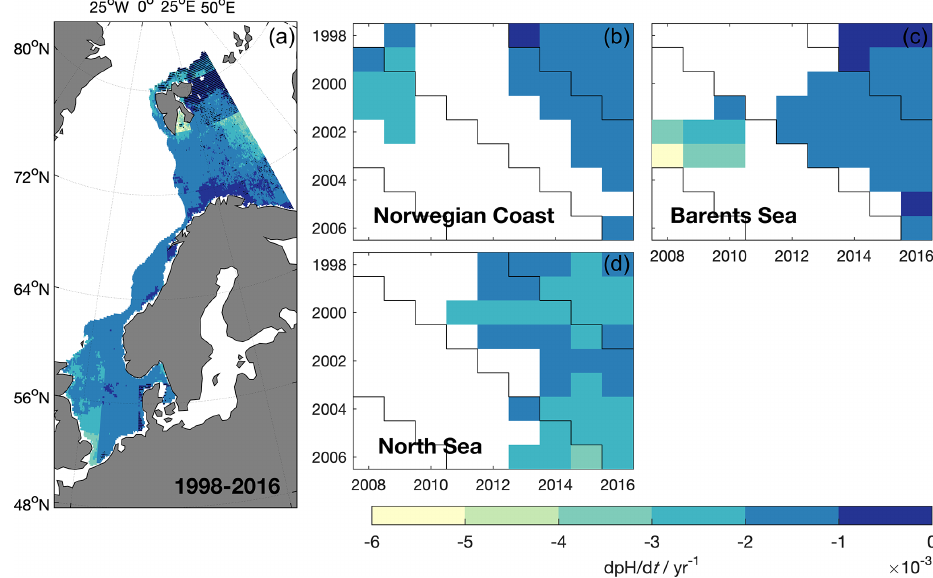
Figure 11. The trend in surface ocean pH estimated from deseasonalized pH. (a) The spatial distribution of the trend over the time period from 1998 to 2016 is shown. Grid boxes without a significant trend are denoted with a black dot. Panels (b) – (e) show the trends in different time periods in three regions, from the various years on the y axis to the various years on the x axis. Non-significant trends were left blank.